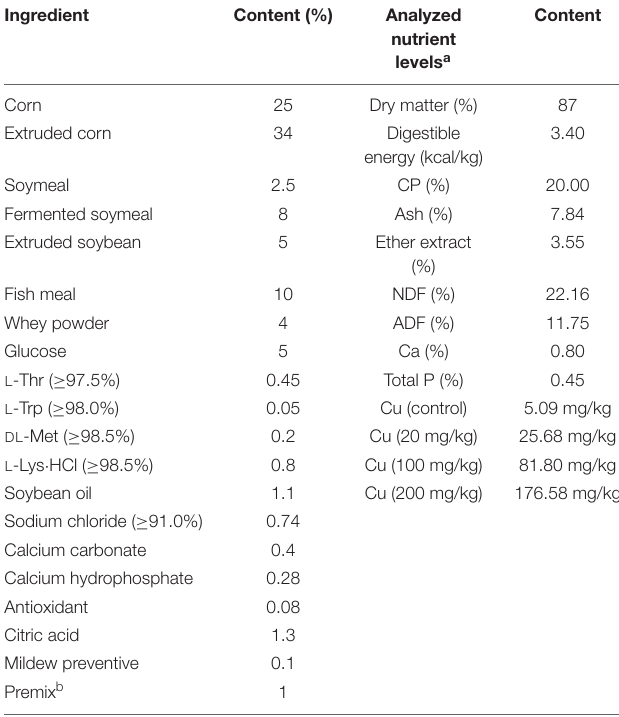
TABLE 1 | Formulation of basal diet (air-dry basis,